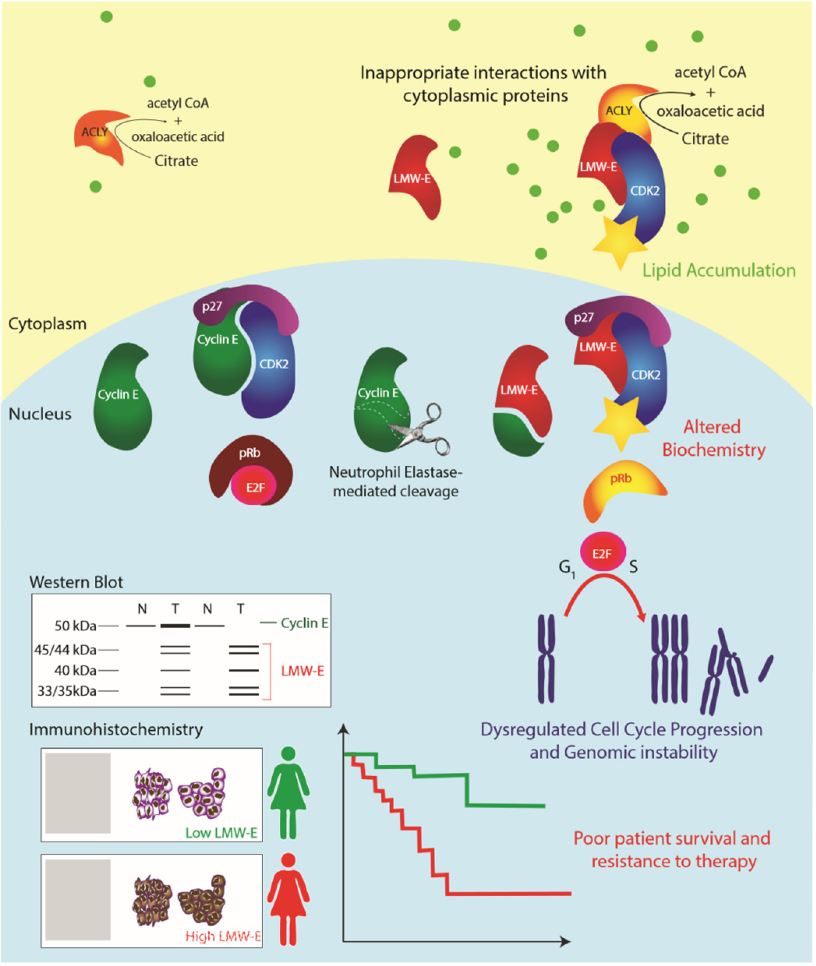
Figure 1. Model: Low molecular weight cyclin E (LMW-E) isoforms are generated by neutrophil elastase-mediated proteolytic cleavage, removing the N-terminal nuclear localization signal. LMW-E isoforms accumulate in the cytoplasm where they inappropriately interact with cytoplasmic proteins, such as ACLY. The altered biochemistry of LMW-E results in hyperactivation of CDK2, resistance to endogenous CDK-inhibitors (p21CIP1 and p27KIP1) and altered substrate interactions, which results in enhanced cell cycle progression, genomic instability and other pro-tumorigenic features. Evaluation of LMW-E by Western blot (protein size) or immunohistochemistry (cytoplasmic localization) is prognostic of poor prognosis and predicts failure of standard treatment modalities.